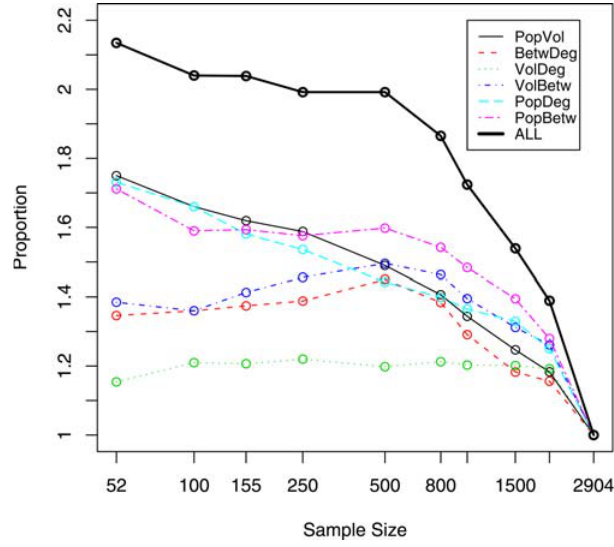
Figure 5. Inflation coefficient indicating the union of two ranking lists is larger than the size of a single list. For each pair of network characteristics, we consider two lists ordered by each of the characteristics. The single list size is shown on the horizontal axis. The inflation coefficient is shown on the vertical axis. The minimum value of the inflation coefficient, 1, occurs when the two lists are identical. This is achieved only in the whole sample. The maximum value of the inflation coefficient for the union of two categories, 2, occurs when the lists do not share any cities. For all four categories the maximum value of the inflation coefficient is 4. The size of the union of 52-city lists in all four categories is 2.2 times larger than the size of a single list, which translates into 114